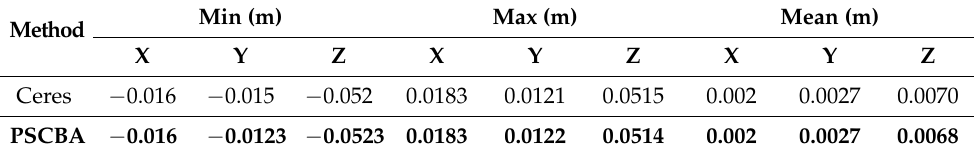
Table 4. Metric of ground control points after bundle adjustment for dataset